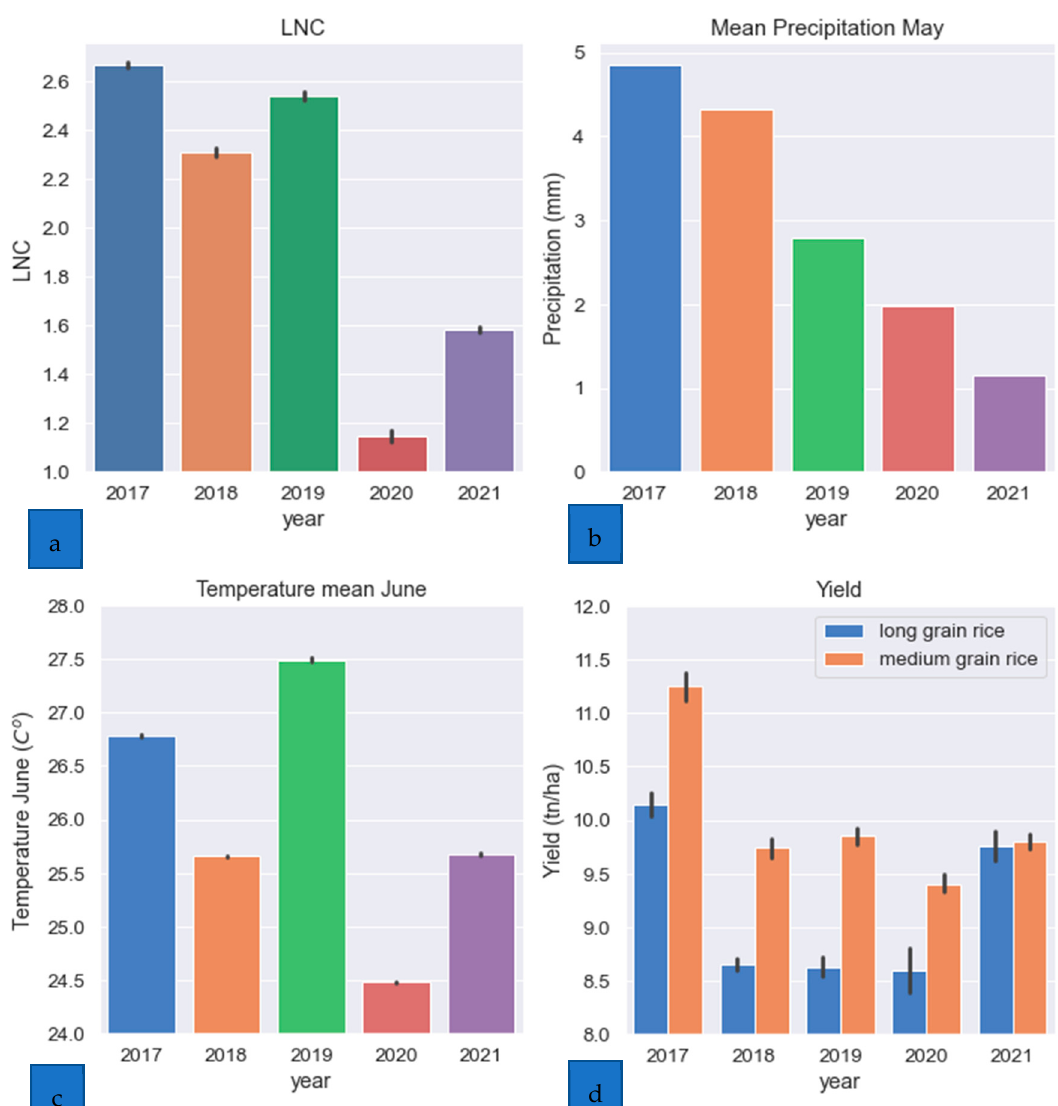
Figure 7. Mean LNC ( a ), mean precipitation for May ( b ), mean temperature for June ( c ) and mean yield for the long- and medium-grain varieties ( d ) for all years of the experiment.